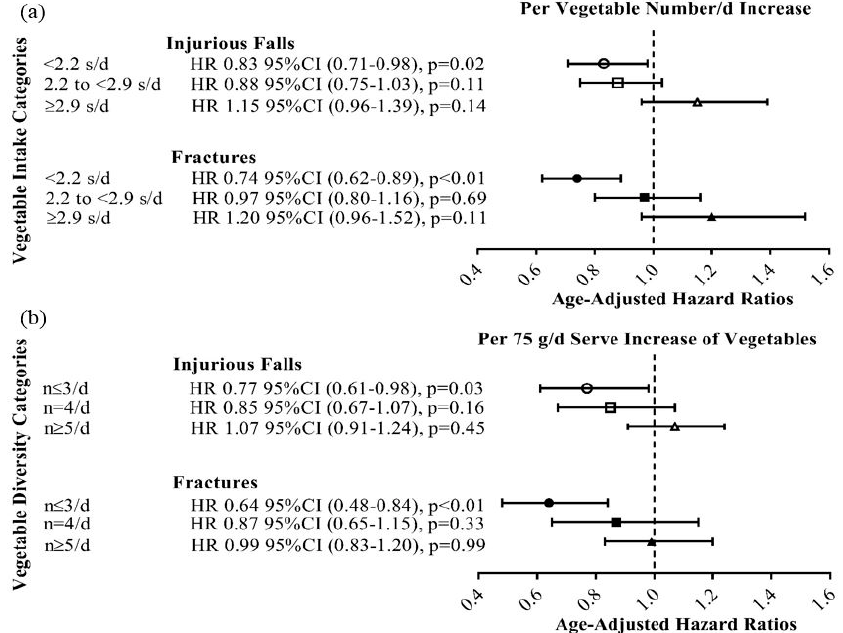
Figure 2. Age-adjusted hazard ratios for injurious falls and fractures based on categories of (a) vegetable intake and (b) vegetable diversity over 14.5 years. Categories for vegetable intake included: low <2.2 s/d ( n = 476), moderate 2.2 to <2.9 s/d ( n = 477) and high ≥ 2.9 s/d ( n = 476). Categories for vegetable diversity included: low <4 n /d ( n = 484), moderate 4 n /d ( n = 440), and high ≥ 5 n /d ( n = 505).